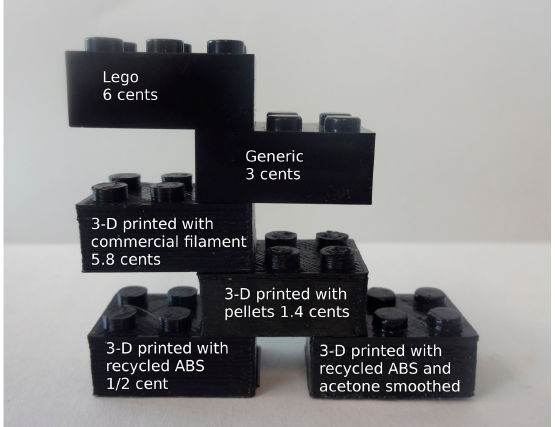
Figure 4. Photograph of 2 × 3 toy bricks: Lego brick, Lego-compatible generic brick, 3D printed commercial ABS and 3D printed recycled acrylonitrile butadiene styrene (ABS) bothnatural and acetone smoothed with costs.